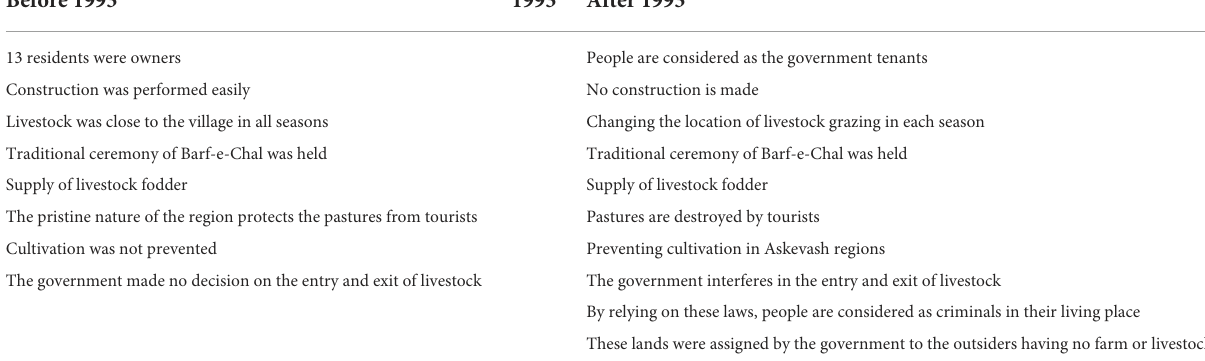
TABLE 3 Results of before and after using the